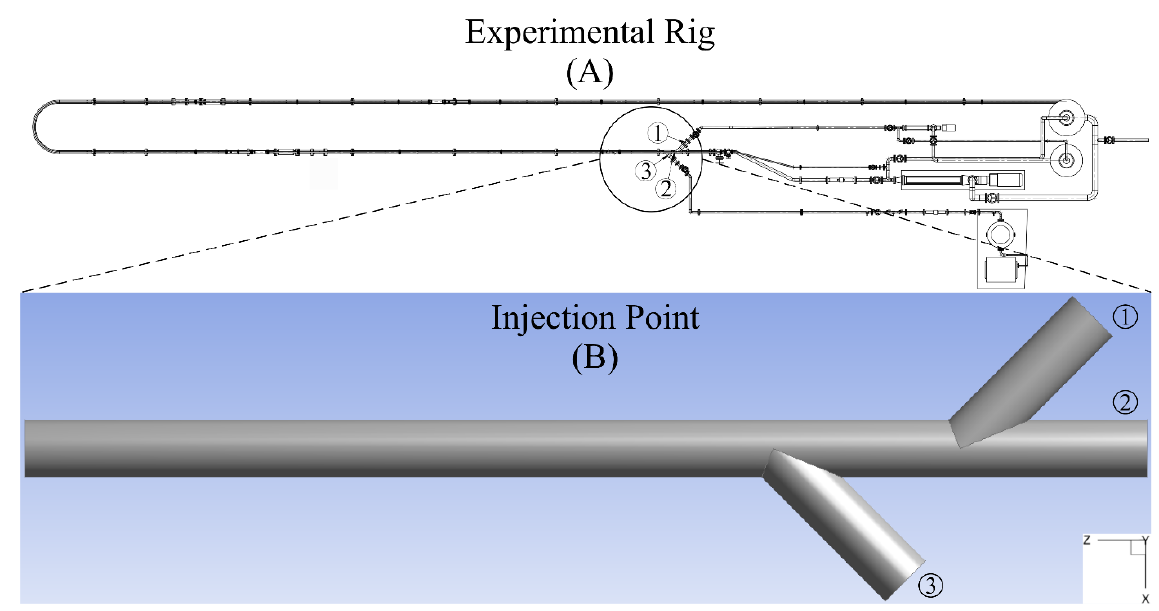
Figure 1. Top view of the complete experimental rig setup ( A ), injection point close-up ( B ). (1), (2) and (3) phases nozzles.